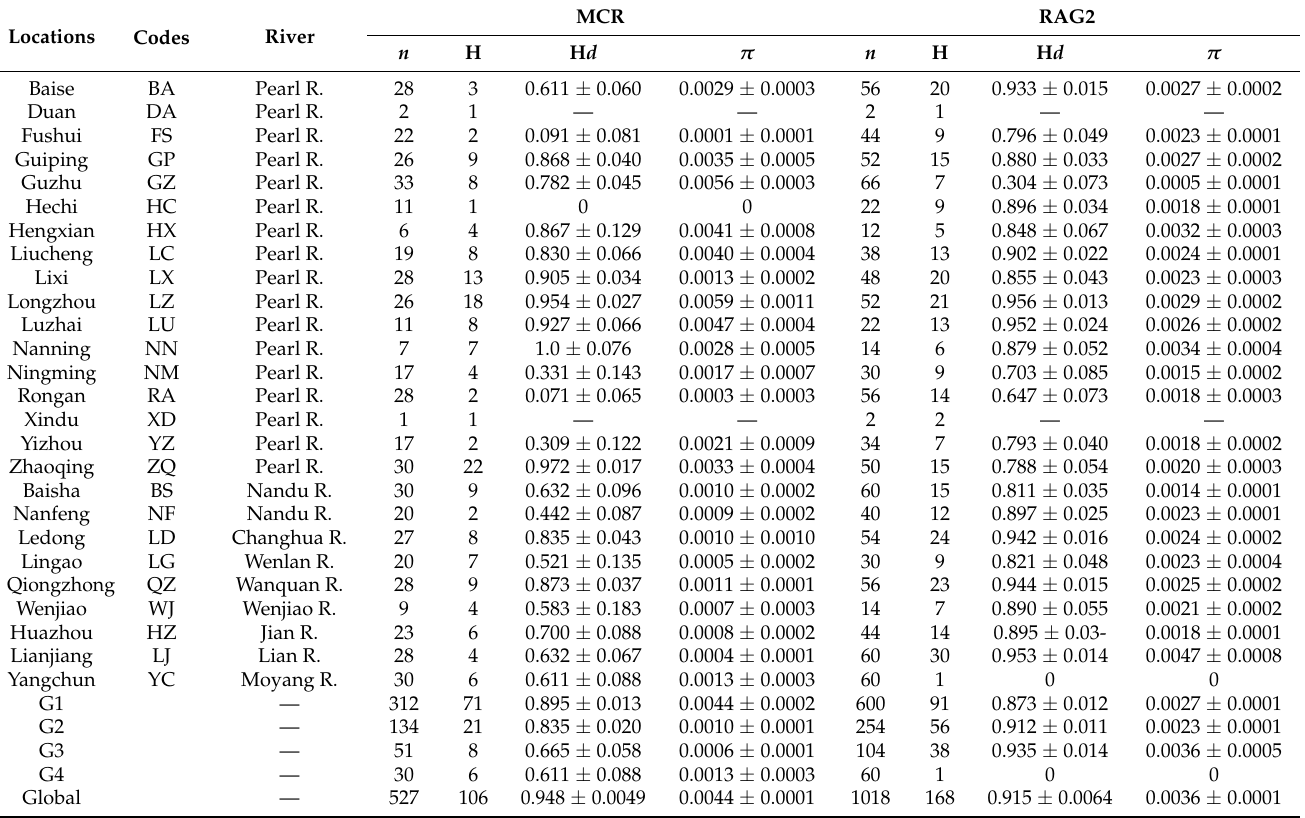
Table 1. Genetic diversity indexes for Toxabramis houdemeri populations based on concatenated mitochondrial locus (MCR) and RAG2 . n , sequence numbers; H, haplotype numbers; H d , haplotype diversity; and π , nucleotide